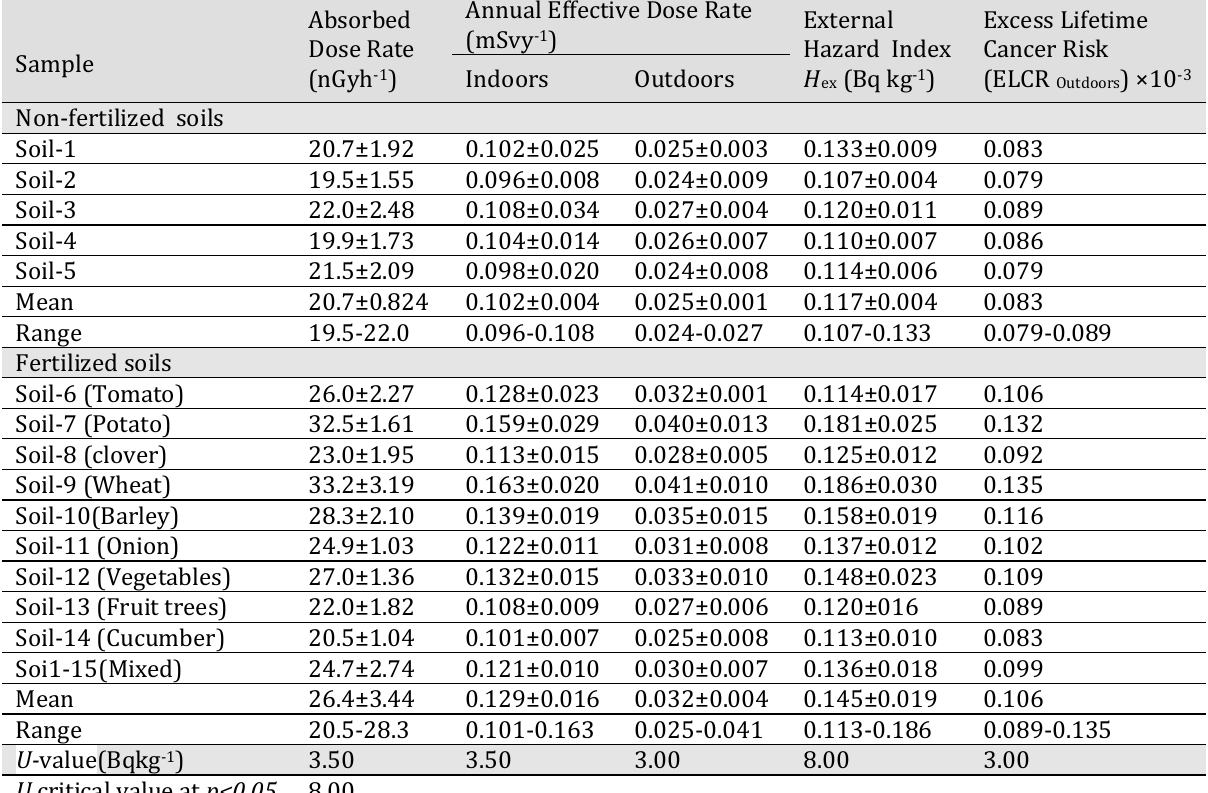
Table 3. Mean values of absorbed dose rate, annual effective dose rate, external hazard index, and excess lifetime cancer risk in the studied soil samples.